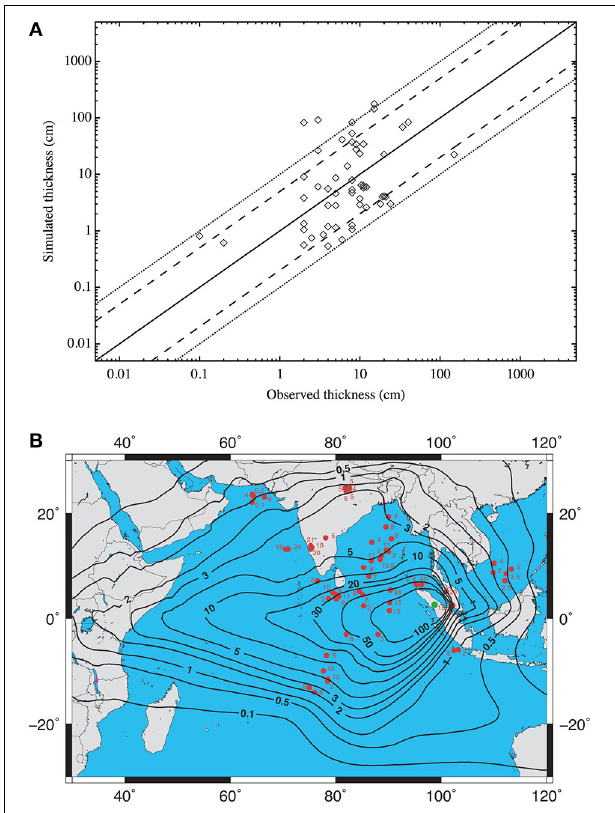
FIGURE 2 | (A) Comparison between the thicknesses from the best-fit FALL3D simulations and the field data, at each of the 57 sampling points (see Table S1 in Supplementary Material for grid references and thicknesses). The solid line represents a perfect agreement, and the dotted and dashed black lines mark the region that is different from observed thicknesses by a factor 10 (1/10) and 5 (1/5), respectively. (B) Isopach maps showing YTT ash thickness in centimeters (intervals 0.1, 0.2, 0.5, 1, 2, 3, 5, 10, 20, 30, 50, 100cm), as modeled using